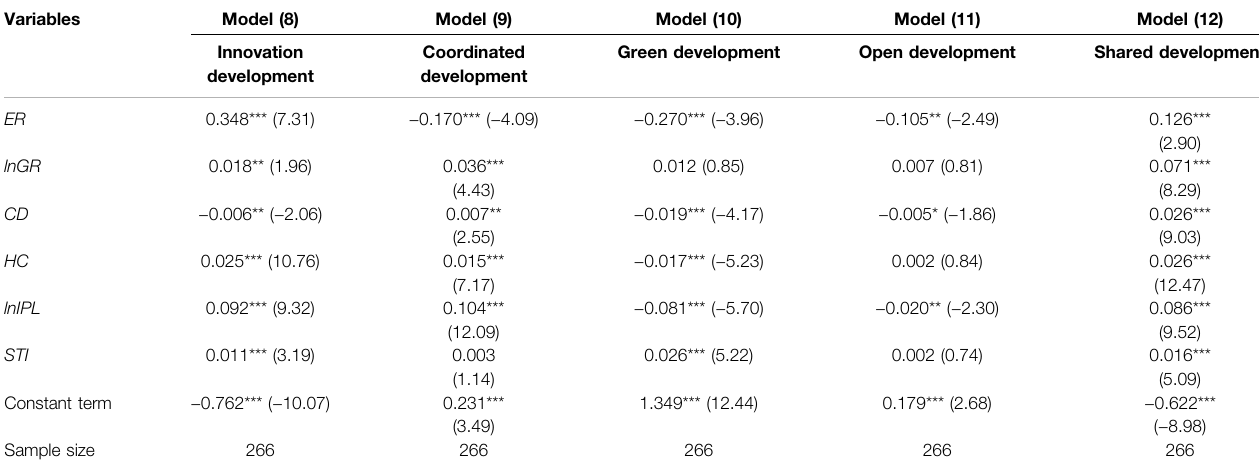
TABLE 5 | Estimation results of environmental regulation on the high-quality development subindex.